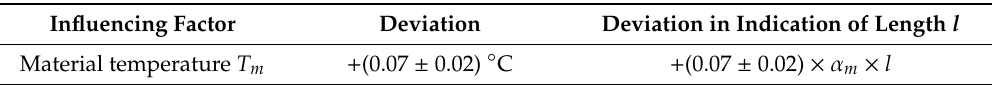
Table 6. Example of a calibration result of a material temperature sensor and the e ff ect on a measured